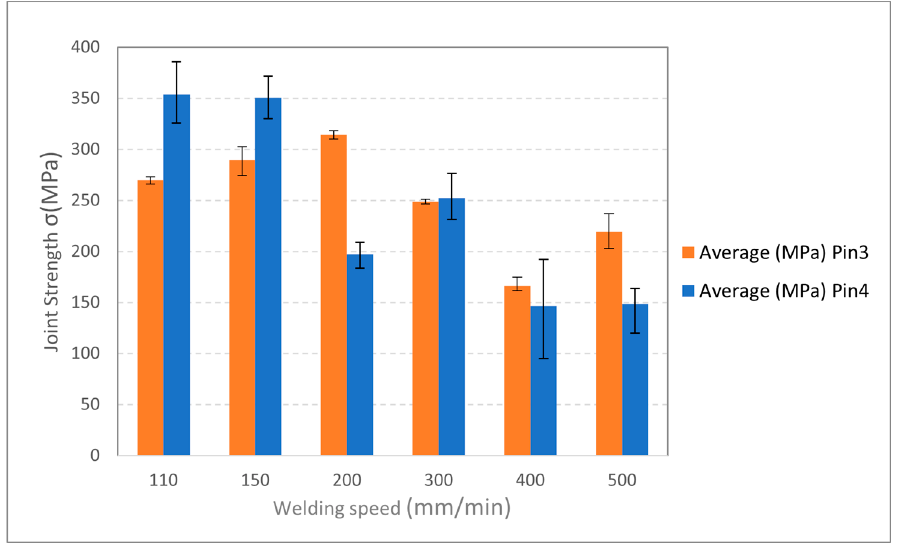
Figure 6. Comparison of Pin3 and Pin4 tool at 1500 rpm.